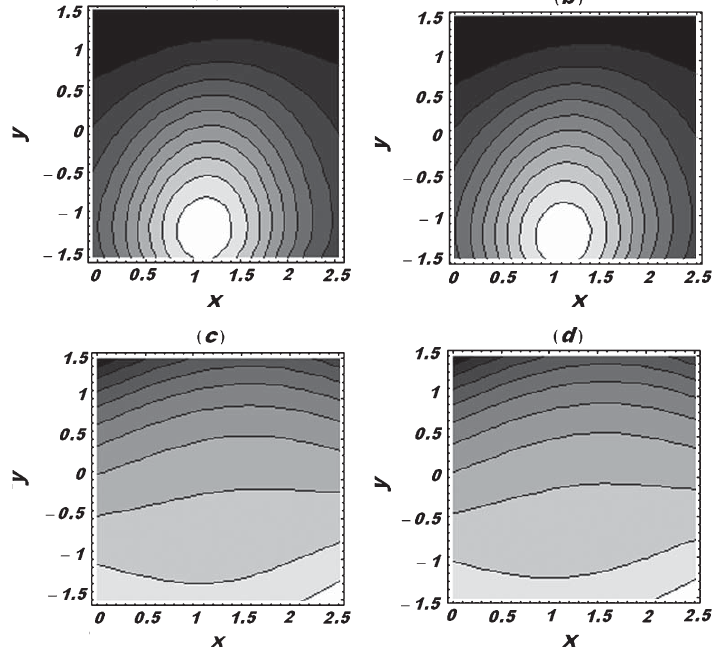
Fig. 23. Streamlines for a = 0 . 5, b = 0 . 7, d = 2, Re = 10, α = 0 . 3, β = 0 . 1, θ = 1 . 35, dp (2) /dx = 1 . 2, φ = π/ 6, (cid:15) = 0 . 1 with different Fr (a) Fr = 1, (b) Fr = 2, (c) Fr = 3, (d) Fr =